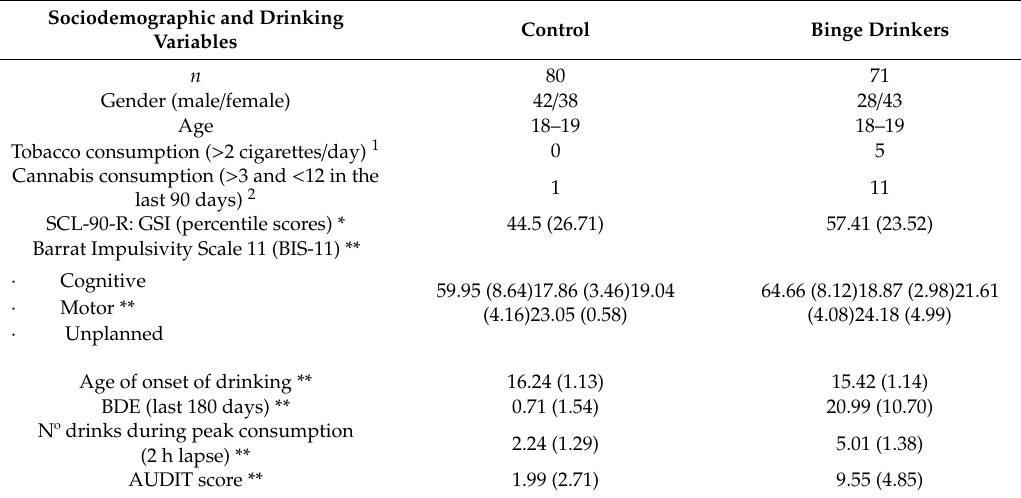
Table 2. Sociodemographic and drinking characteristics of the Control and BD groups with mean (SD): Significant di ff erences between groups are indicated according to the p